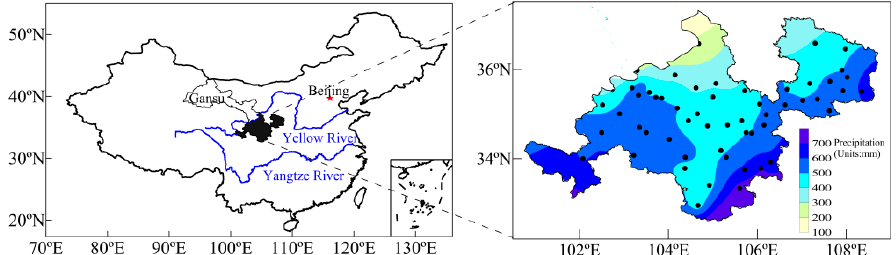
Figure 1. Distribution of annual average precipitation (unit: mm) and the location of the study area, meteorological stations (black spots).